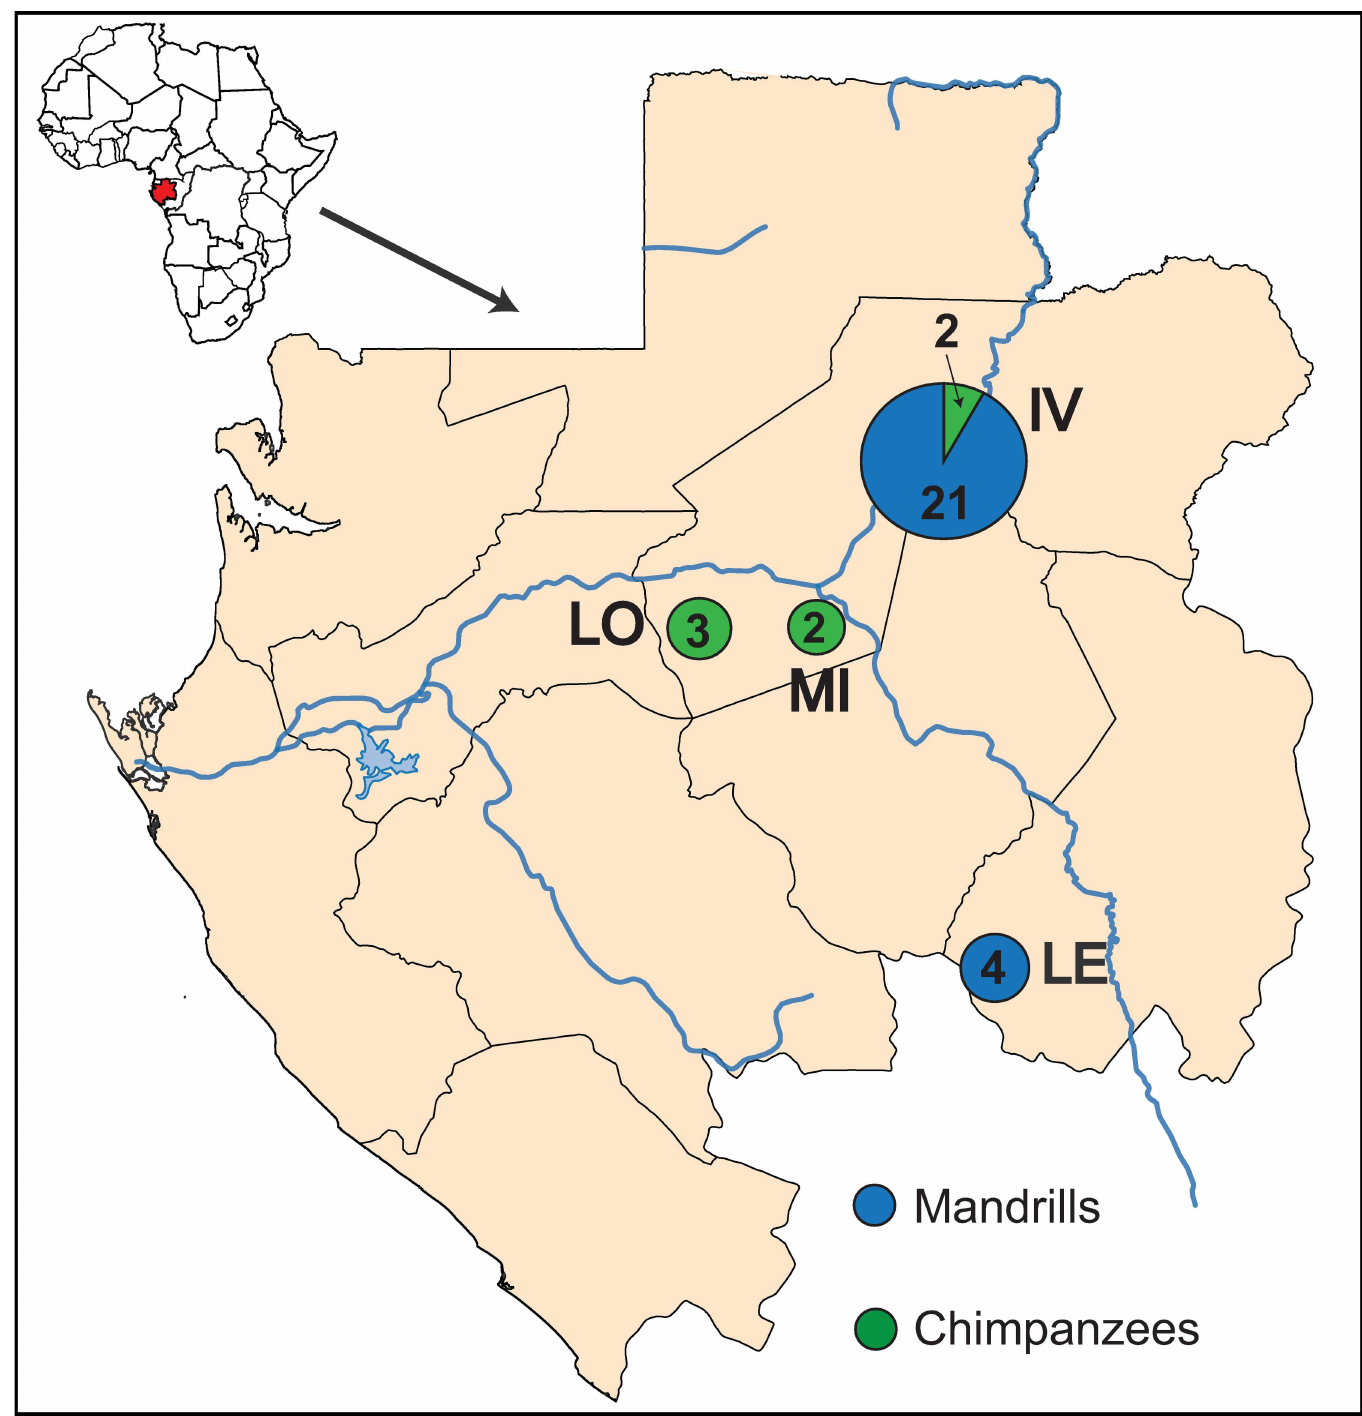
Fig 1. Non-human primates sampling sites in Gabon. For each site, the zone code is indicated: IV for Ivindo, LE for Le´ke´di, LO for Lope´, MI for Mikongo. The circles indicate positive EV samples detected in this study; numbers insidecircles indicate the numberof positive EV samples. Host species that yielded EVs are indicatedin blue for chimpanzee and green for